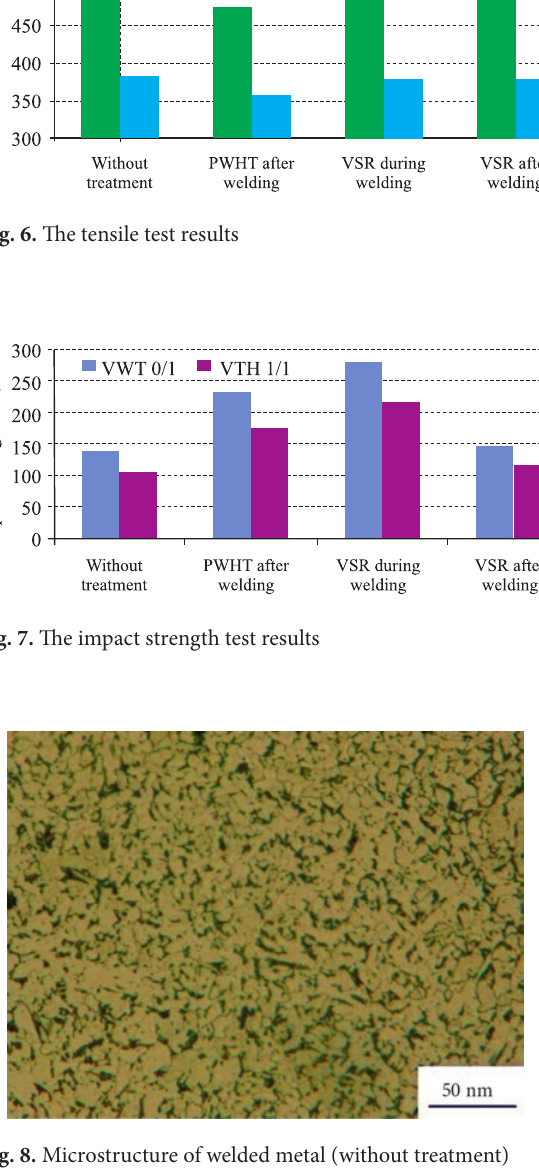
Fig. 8. Microstructure of welded metal (without treatment)